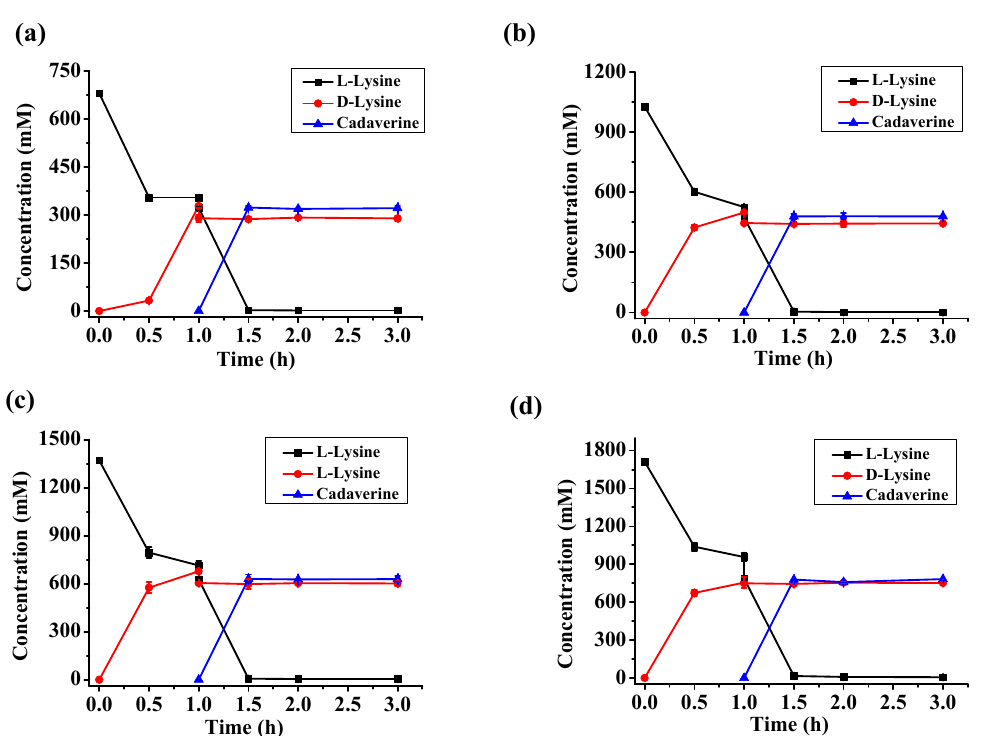
Figure 6. The production of D -lysine from different concentration of L -lysine. The intial L -lysine was 680 mmol/L ( a ); 1030 mmol/L ( b ); 1370 mmol/L ( c ); and 1710 mmol/L ( d ), respectively.